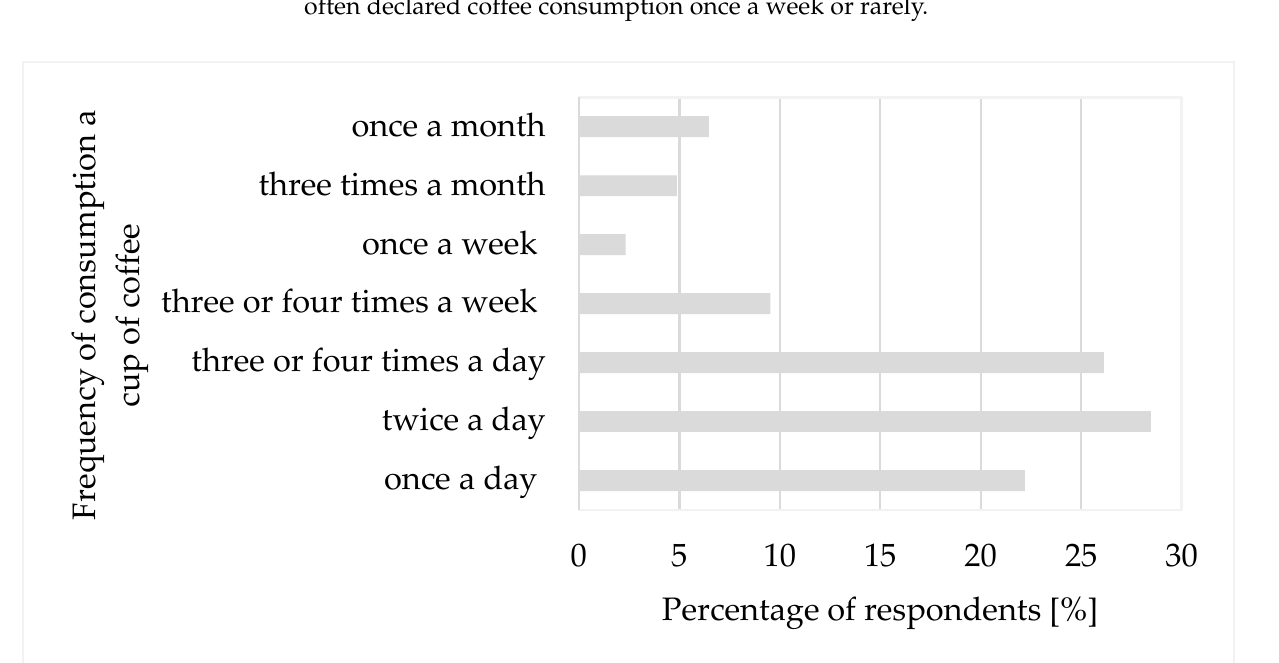
Figure 1. Frequency of consumption coffee by respondents.